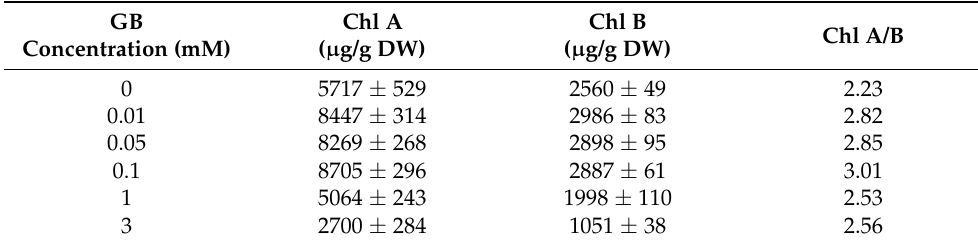
Table 1. Variations in chlorophylls a (Chl A) and b (Chl B) upon exposure to GB in concentrations up to 3 mM. The quantifications were carried out using HPLC-DAD. The results are given as mean ± SD.